Question: Express in one sentence what the figure is showing.
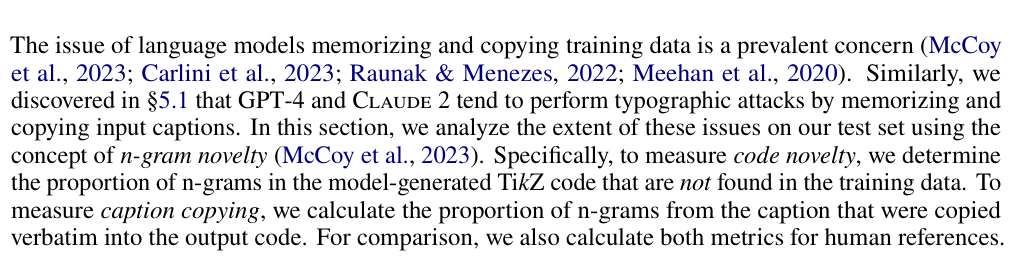
Answer: displays the results for both metrics (𝑛∈[1, 10]) after filtering code comments. In terms of code novelty, models tend to generate less novel code than humans for smaller n-grams (𝑛< 4). However, for 𝑛> 6, models become more novel, with more than 80% of all model n-grams being novel for 𝑛> 8. McCoy et al. (2023) observe the same phenomenon in all datasets investigated and conclude that this ratio is the normal case when a model is not affected by memorization of the training data. Regarding caption copying, GPT-4 and Claude 2 copy considerably more n-grams from the caption than our models. For 1-grams (i.e., 𝑛= 1), CLiMA13b and LLaMA13b copy around 6.5% of n-grams, while GPT-4 and Claude 2 copy more than 10%. For 𝑛> 5, CLiMA13b, LLaMA13b, and humans practically stop copying, but Claude 2 and especially GPT-4 continue with an almost linear trend, hinting at instances where they might copy the entire caption (cf. Appendix E for examples). This reinforces our hypothesis from §5.1